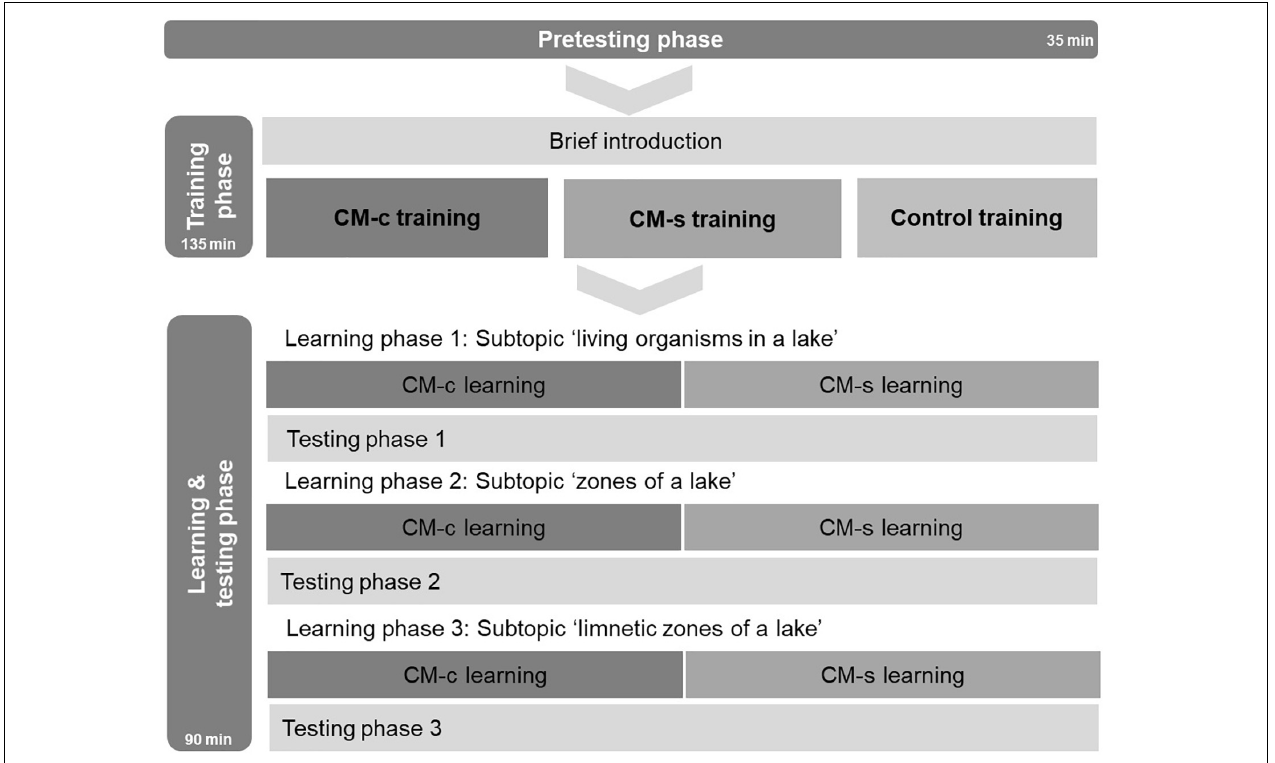
FIGURE 1 | Study design and procedure. Participant allocation can be obtained from Supplementary Material 1